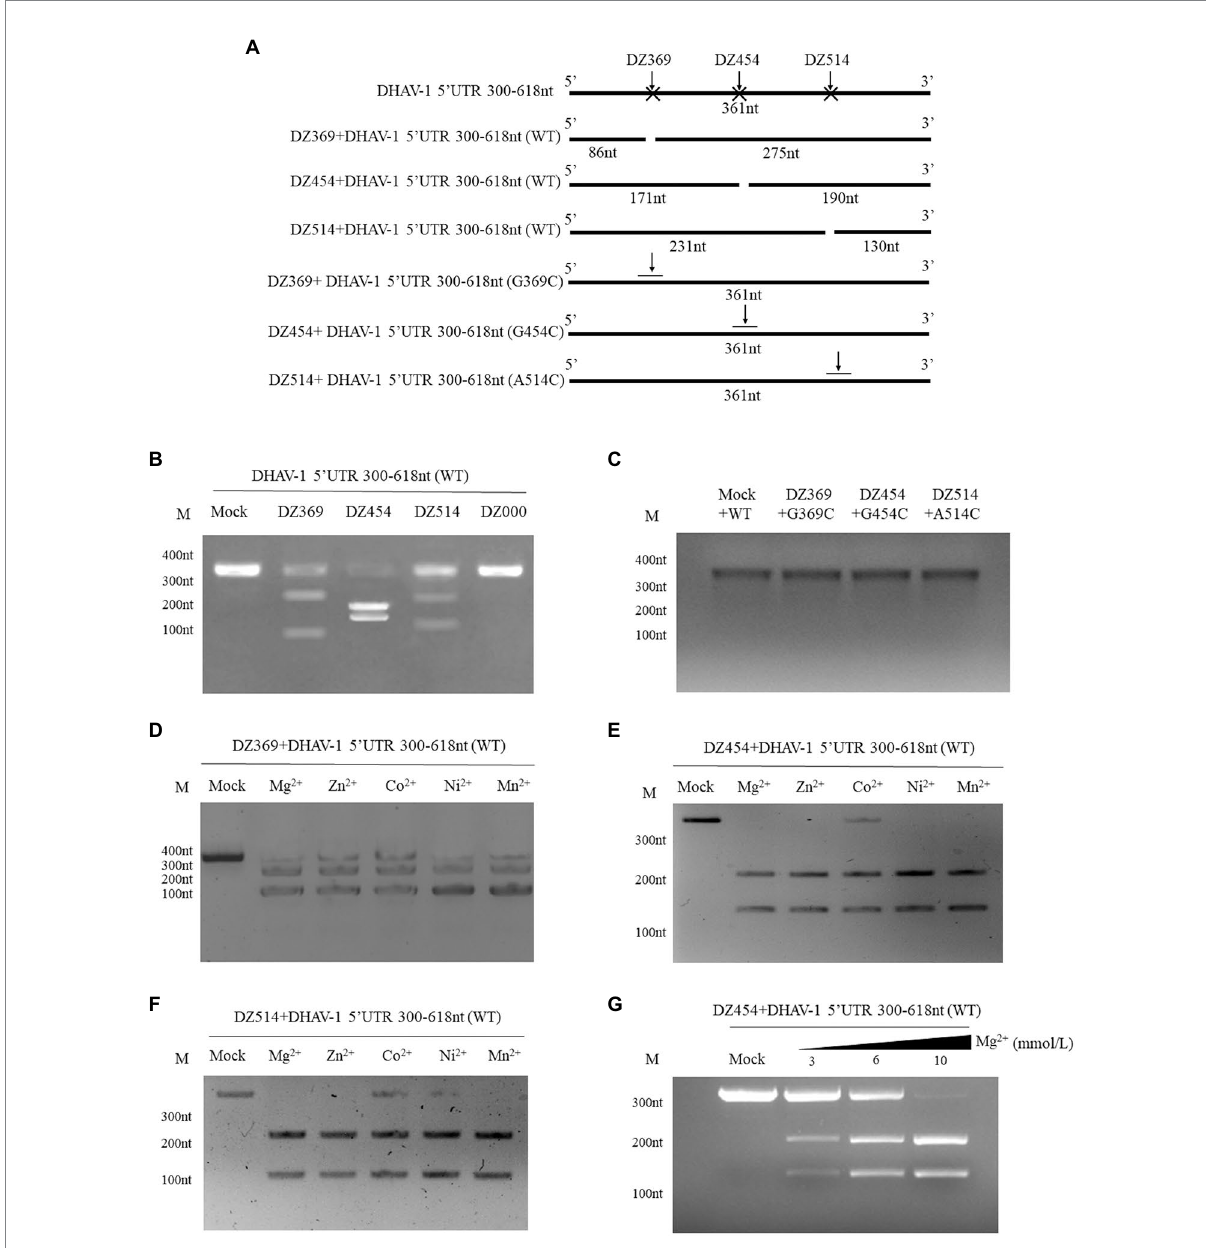
FIGURE 3 Different DNAzymes cleave the DHAV-1 5 ′ UTR 300–618 nt sequence in vitro . (A) Schematic representations showing the Dz cleavage sites on the 300–618 nt sequence in the DHAV-1 5 ′ UTR and some mutants (G369C, G454C and A514C) associated with cleavage sites; the size of the cleaved fragment is shown. (B) In the presence of Mg 2+ , the 300–618 nt DHAV-1 5 ′ UTR RNA (WT) reacted with various Dzs, and the cleaved fragments were analyzed via 5% agarose gel electrophoresis. (C) In the presence of Mg 2+ , the 300–618 nt DHAV-1 5 ′ UTR RNA mutants reacted with various Dzs, and the fragments were analyzed via 5% agarose gel electrophoresis. (D-F) With the addition of Mg 2+ , Zn 2+ , Co 2+ , Ni 2+ , and Mn 2+ , DZ369, DZ454 and DZ514 cleaved target RNA in vitro , as analyzed via 5% agarose gel electrophoresis. (G) With the different concentrations of Mg 2+